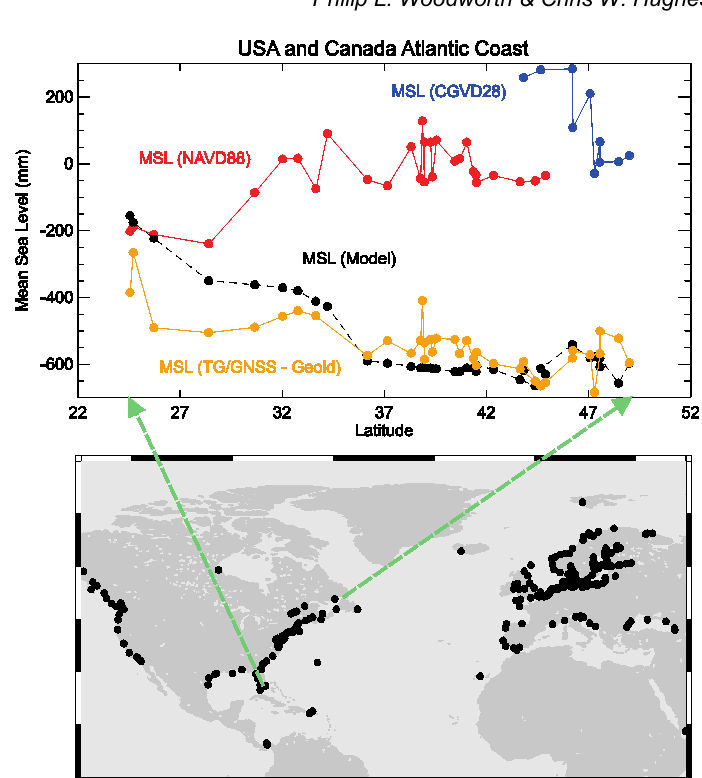
Fig. 1 The apparent north–south slope of MSL along the Atlantic coast of North America derived by three different methods: measured at tide gauges with respect to national datums in the US and Canada (red and blue dots, respectively); determined at the same locations by calculating MSL above the geoid using the state-of-the-art Extended GOCO03S geoid model (yellow dots); and as inferred from a numerical ocean circulation model (black dots). Based on a figure in Woodworth et al.